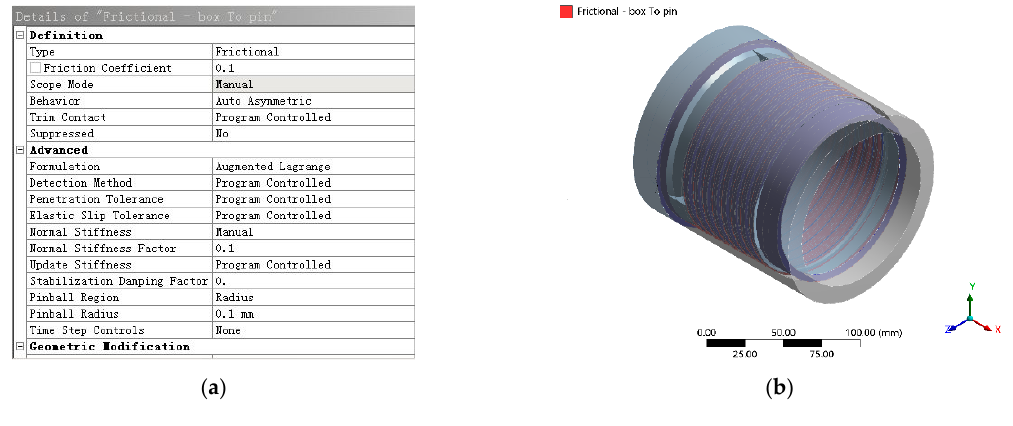
Figure 7. ( a ) Contact settings and ( b ) contact surfaces.